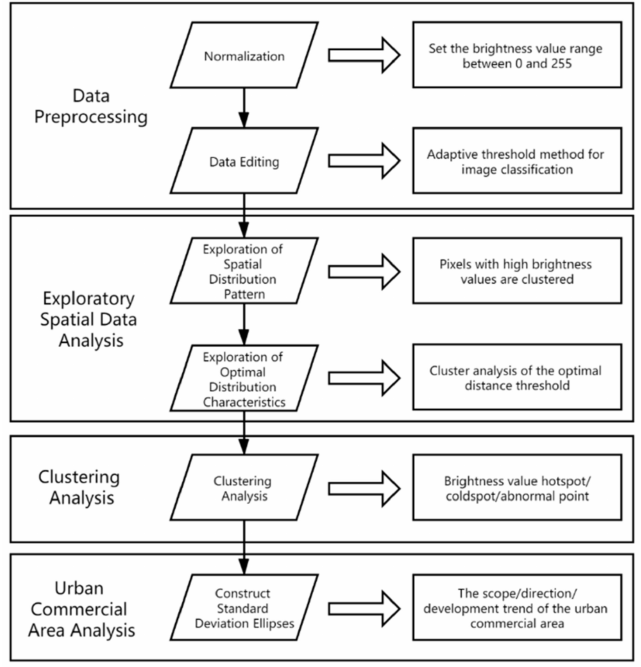
Figure 1. The algorithm flowchart for the urban commercial area identification and extraction based on the nighttime lights satellite